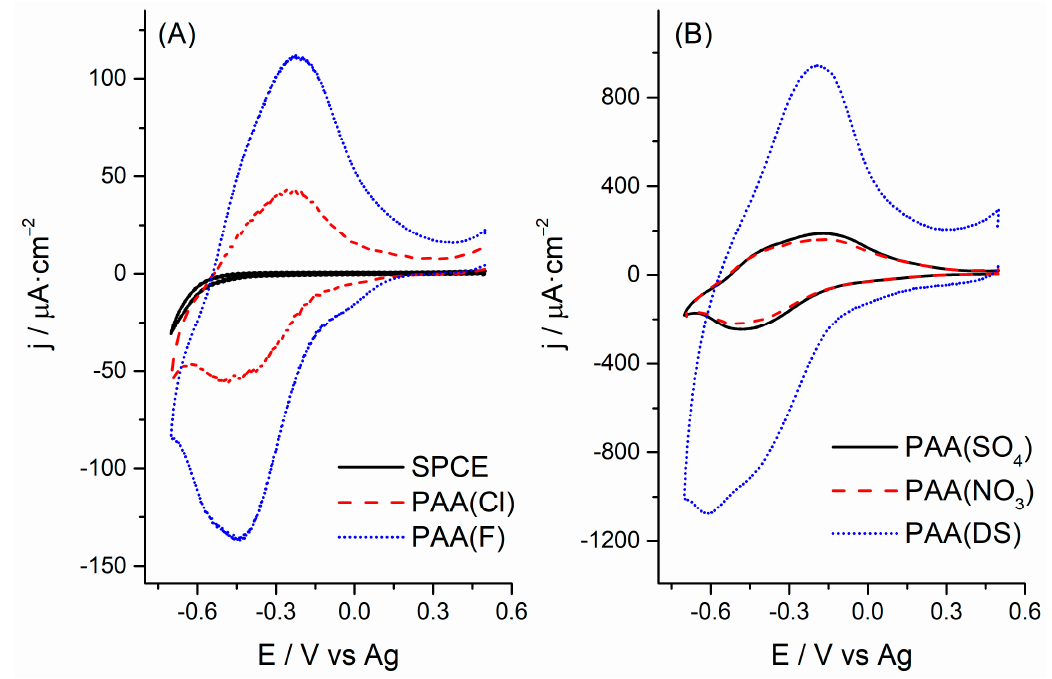
Figure 2. Cyclic voltammograms obtained at a bare SPCE ( A ) and the modified SPCEs with the different PAA films (PAA(Cl) and PAA(F) in ( A ), and PAA(SO 4 ), PAA(NO 3 ) and PAA(DS) in ( B ) at a scan rate of 50 mV·s − 1 in 0.1 M phosphate buffer (pH 7).